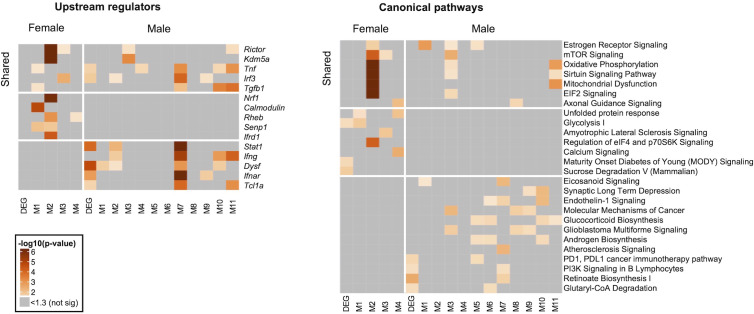
Upstream regulators and canonical pathways associated with APOE4 baseline difference in male and female APOE-TR mouse.